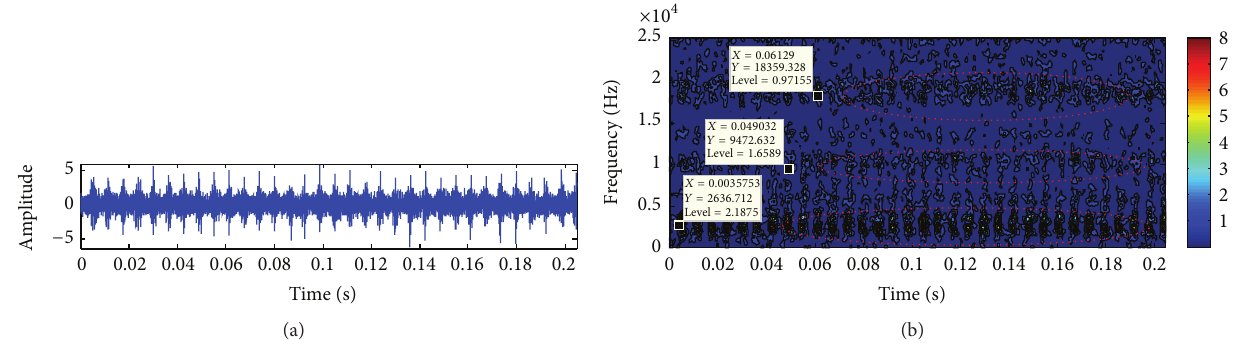
Figure 21: Severe fault vibration signal of the test bearing: (a) time waveform; (b) time-frequency representation.